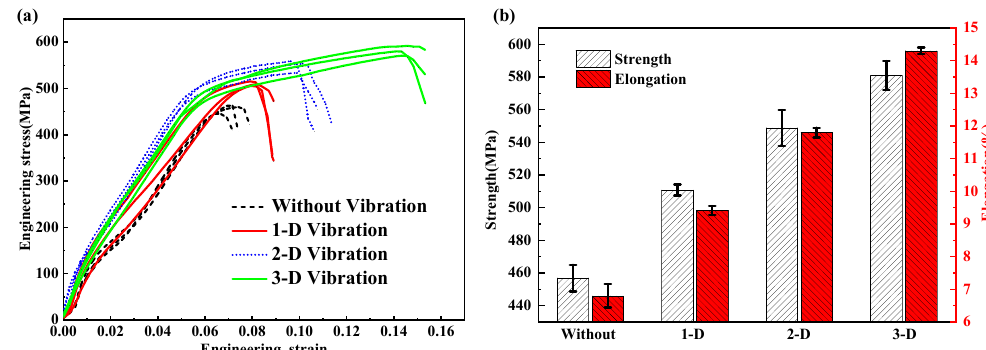
Figure 8. Tensile properties with various vibration conditions: ( a ) stress–strain curves of the axial tensile tests; ( b ) comparison of the tensile strength and elongation.